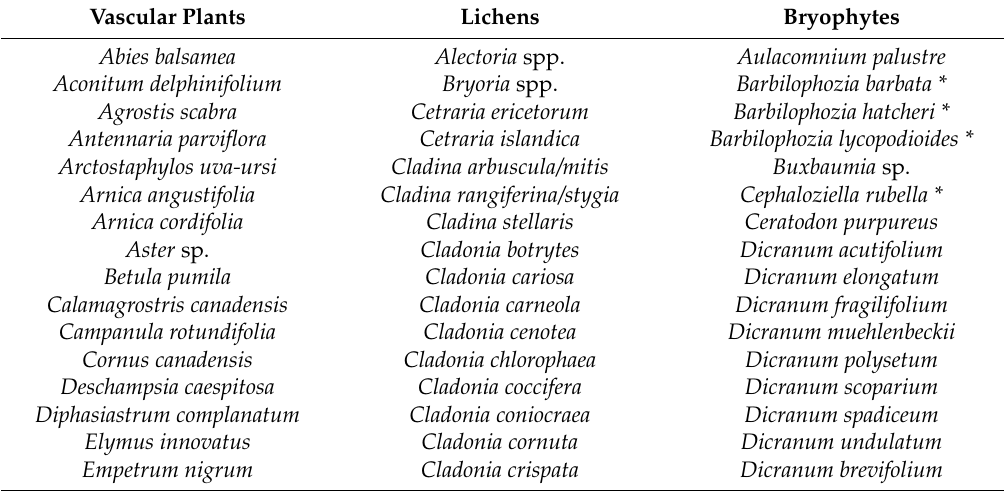
Table A1. List of all species found in the 2017 survey of 97 plots in pine-dominated forests in western Alberta, Canada that were commercially thinned to reduce canopy cover. * =